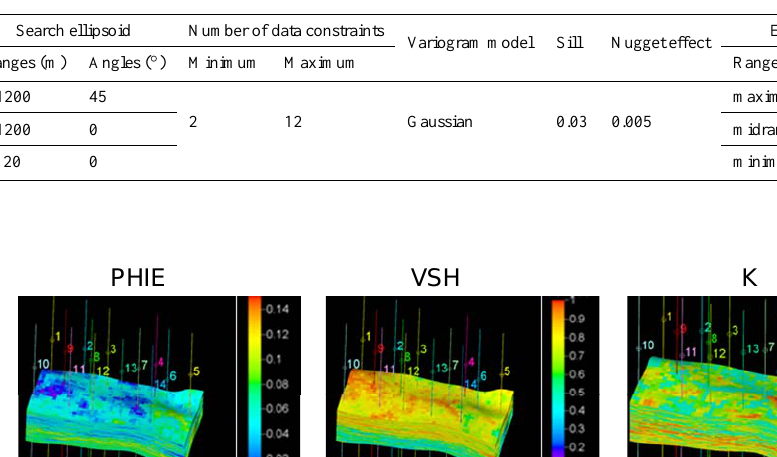
Fig. 7. Fractal distributions of effective porosity (PHIE), shale volume (VSH) and permeability (K) for zones 1 and 2.